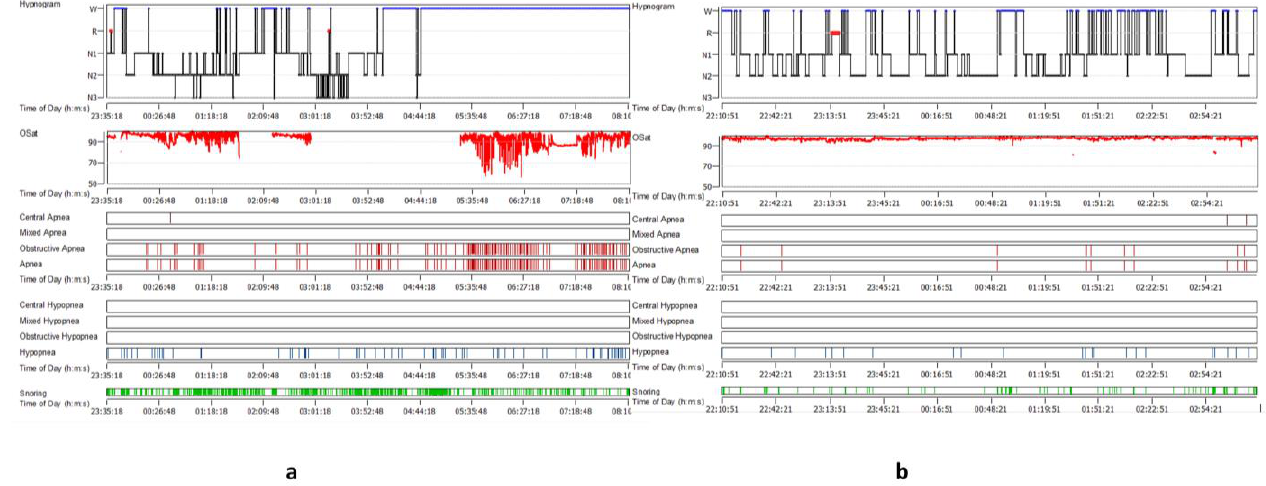
Figure 3. ( a ) PSG of patient with severe OSA, LTH grade 4 before the operation; ( b ) PSG after lingual